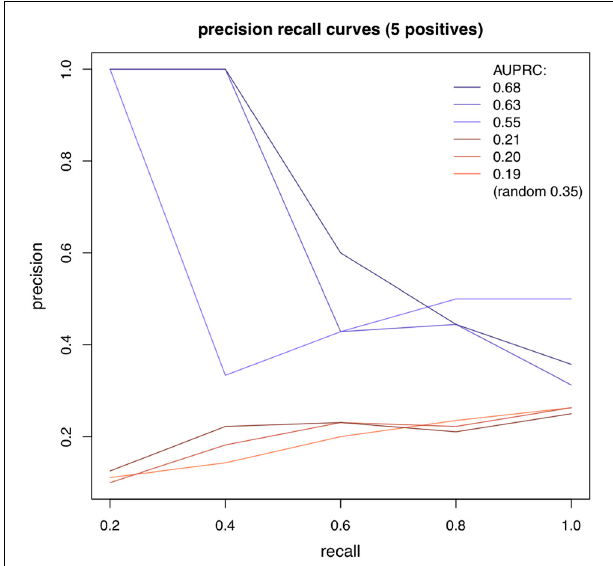
FIGURE 1 | Precision-recall